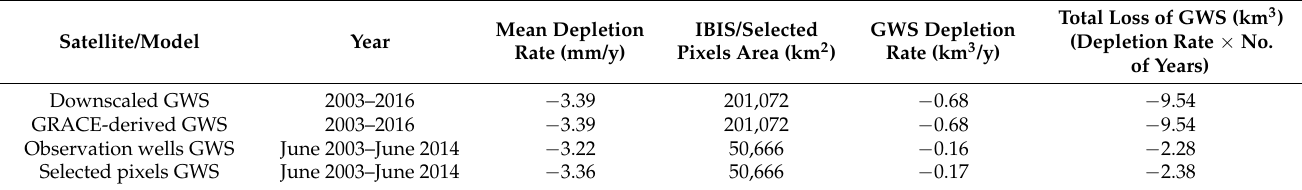
Table 2. Trend and volumetric calculation of